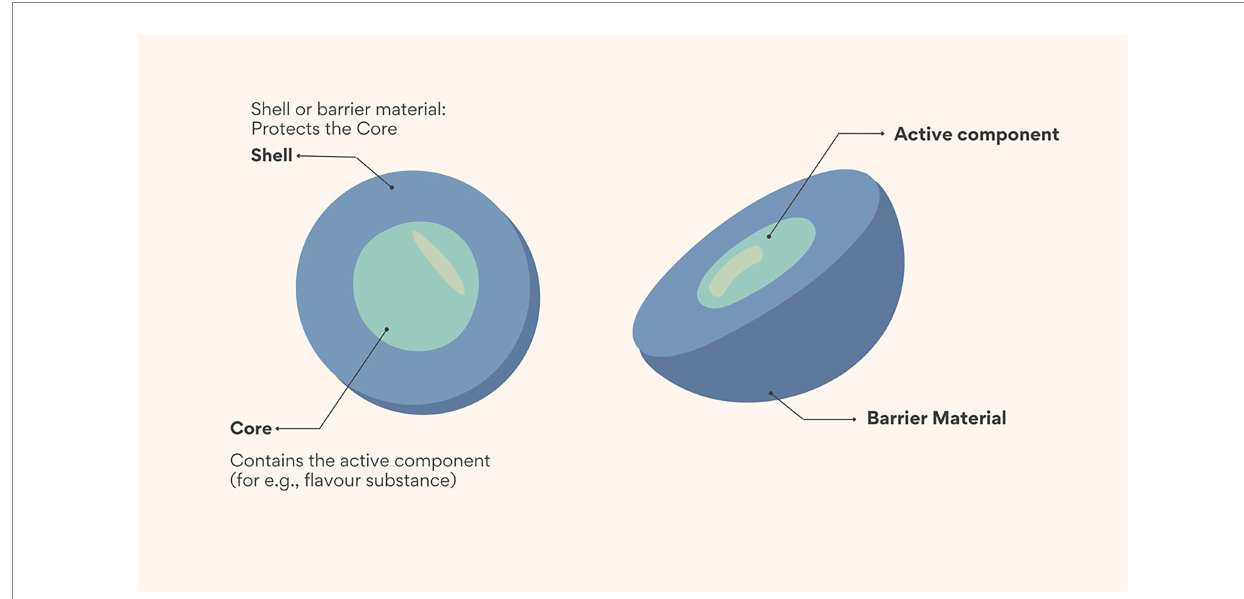
FIGURE 1 Schematic showing the main structure of a microcapsule. Shell (also referred to as wall or carrier materials) are used as a physical barrier to trap core or active components such as flavour